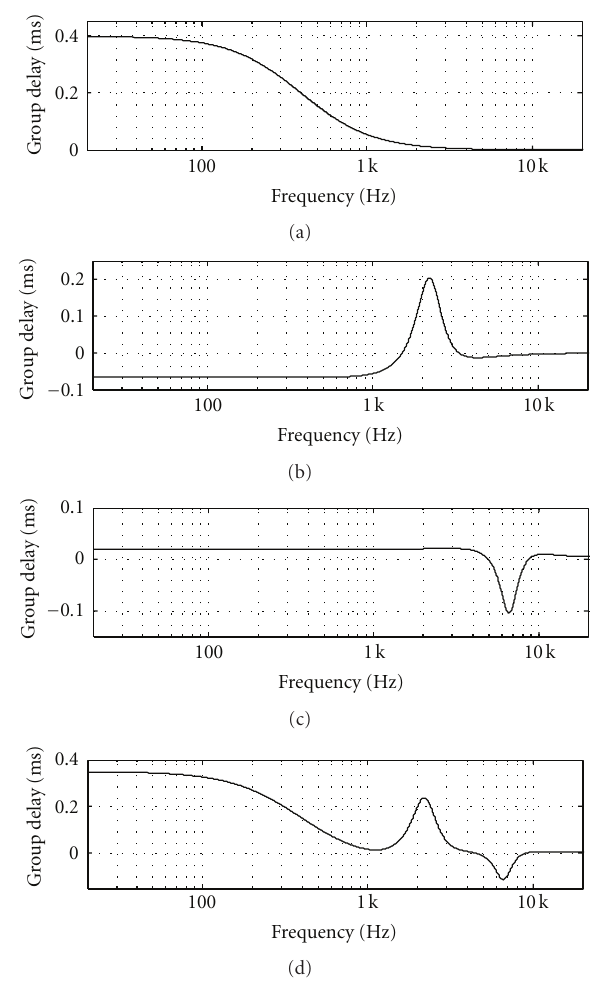
Figure 13: Group delays of the digital filters in the ARA equalizer: (a) the first-order Butterworth highpass filter, (b) the biquad peak filter, (c) the biquad notch filter, and (d) the combined delay of the three filters.